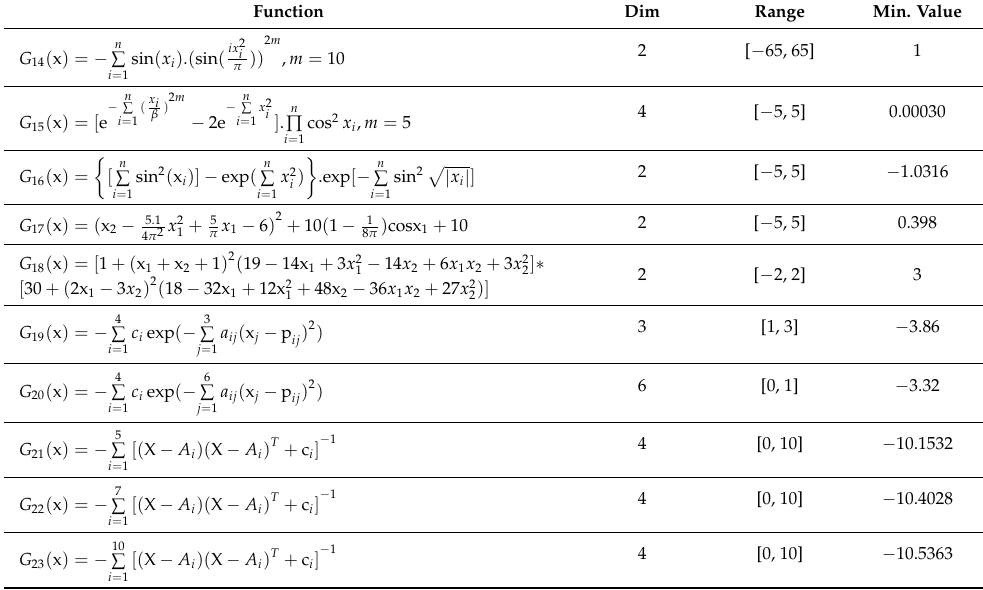
Table 4. Fixed-Dimension Multimodal Benchmark